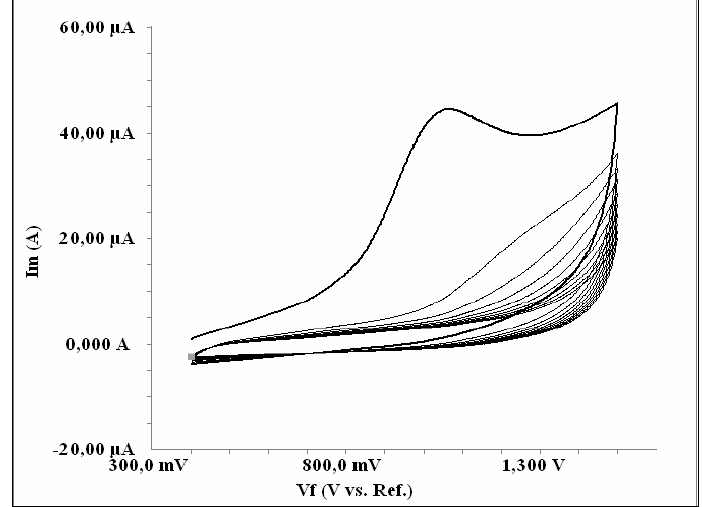
Figure 7. Cyclic voltammograms of quercetin on aminophenyl modified glassy carbon electrode